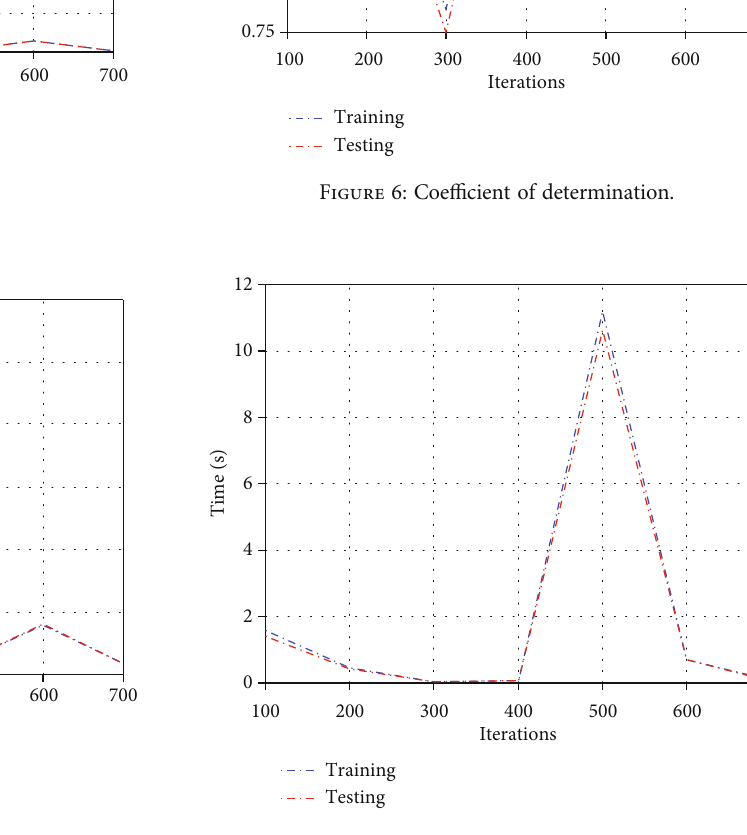
Figure 7: Computational time.